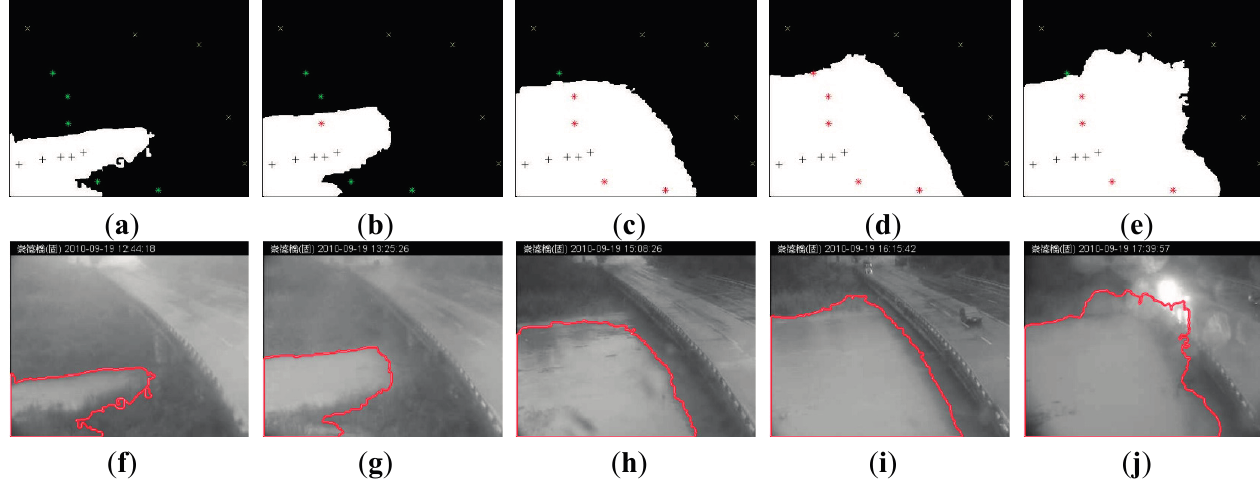
Figure 5. Test results of a real-life case. Figures ( a ) to ( e ) show the foreground seed points (+), the background seed points (x), and the preset warning points in green (*) marks in the processed binary images. In these binary images, the white segments indicate the detected water area, while the black segments show the background objects (e.g., ground, the sky, and bridge) to be deleted. Figures ( f ) to ( j ) show the flooding area detected from the input video, indicated by the red